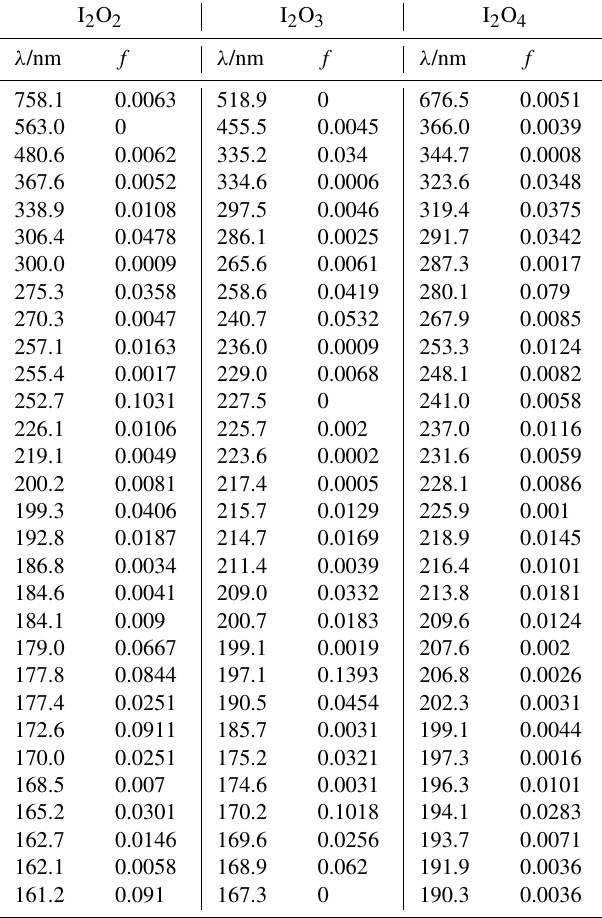
Table A3. Peak wavelengths and oscillator strengths ( f ) for the first 30 excited states of I 2 O 2 , I 2 O 3 , and I 2 O 4 at the TD/B3LYP/G2 level of